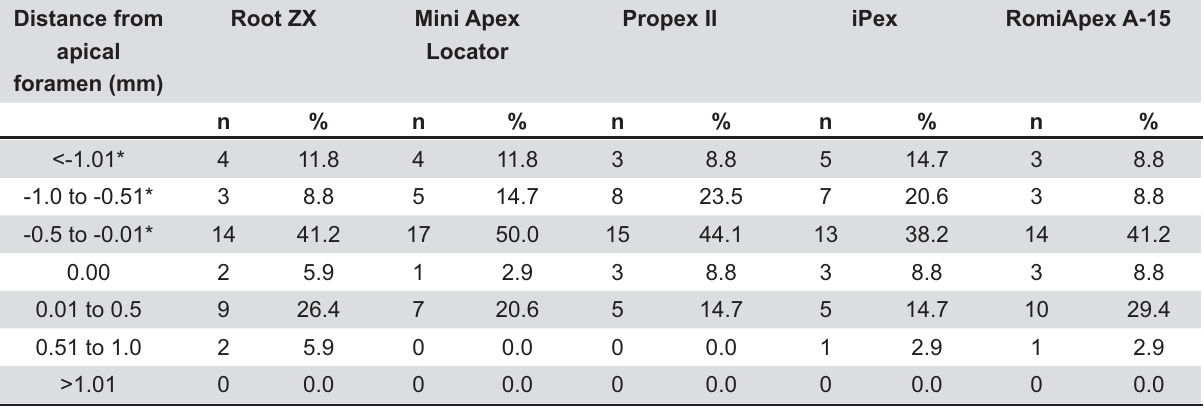
Table 2- File tip position relative to the apical foramen for measurements performed to